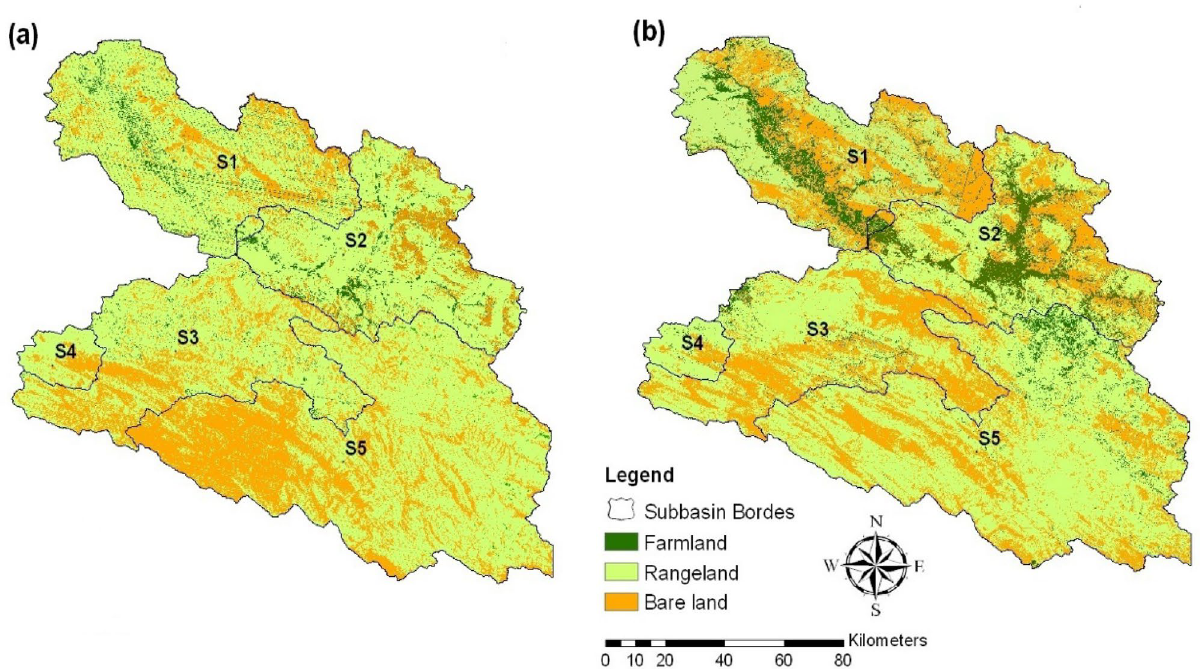
Figure 7. Land-use map of the study area in 1967 ( a ) and 2016 ( b ). This figure is created using version 10.2 of ArcGIS software (https:// www. arcgis.